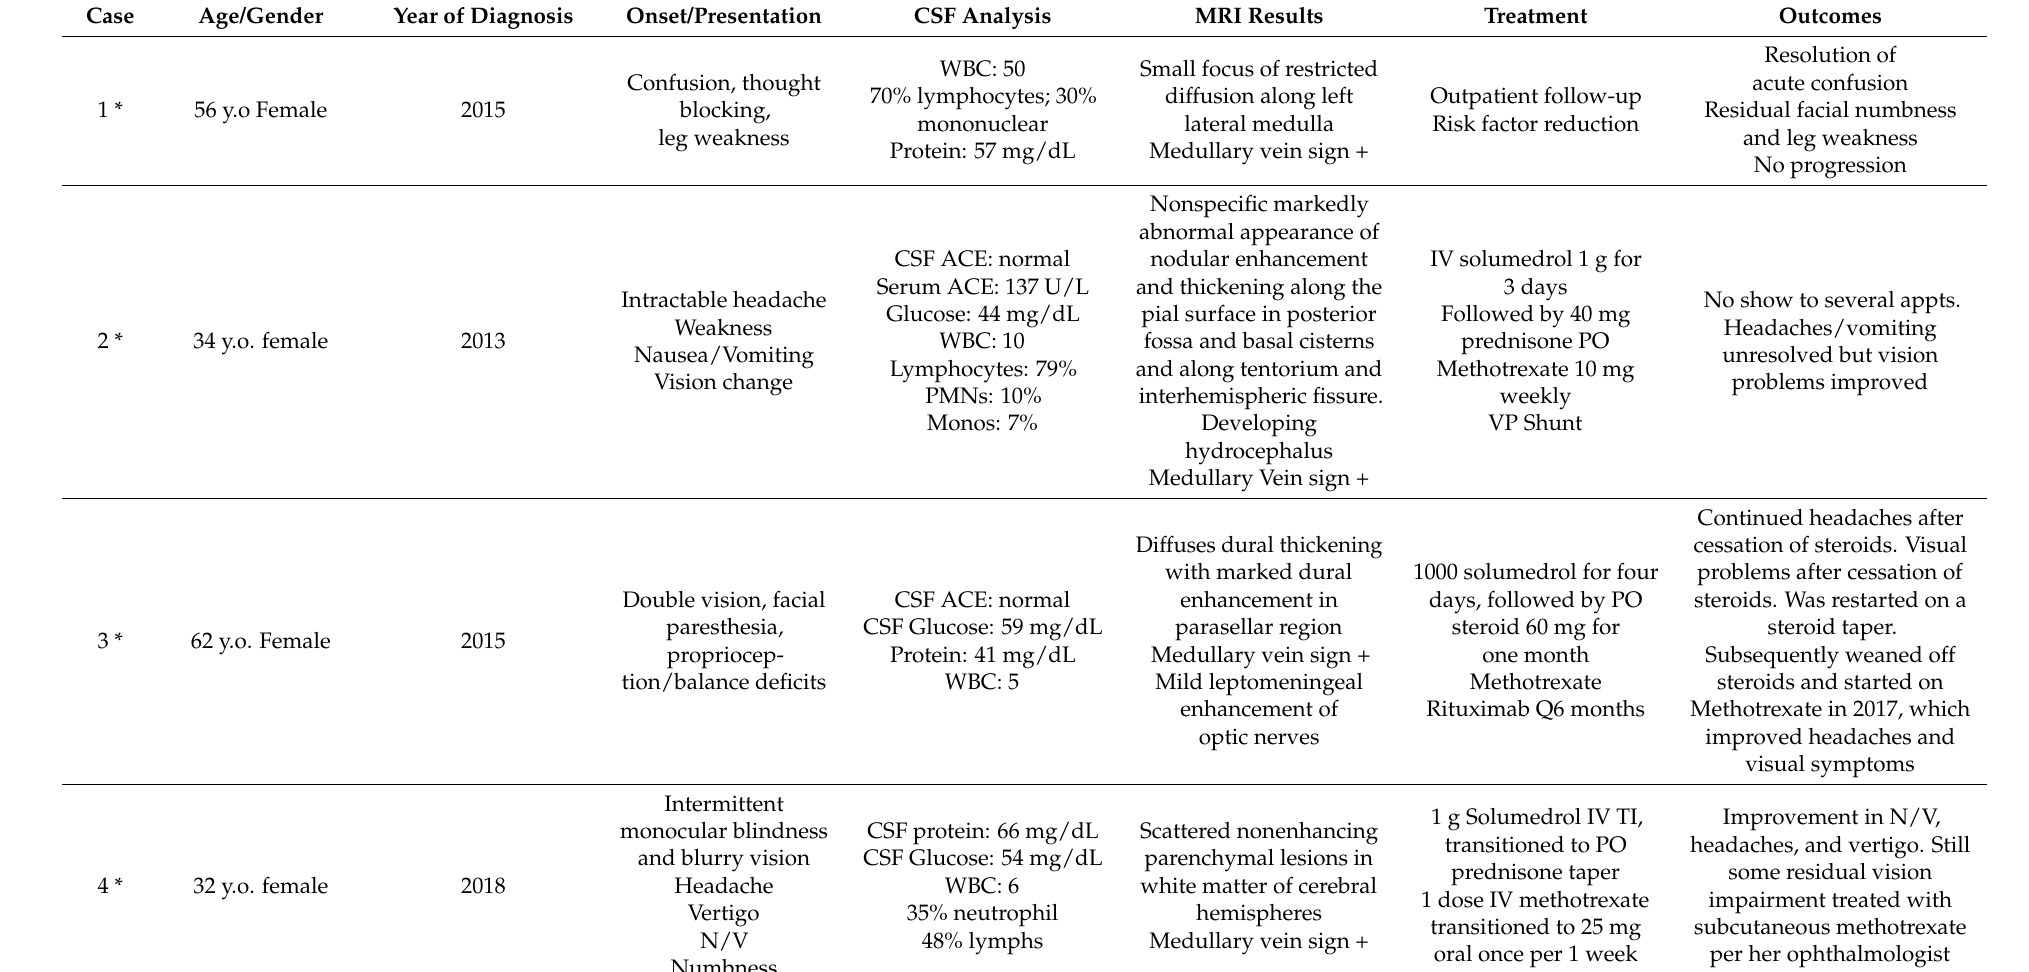
Table 1. MRI Imaging and image analysis findings. The table lists five cases of confirmed neurosarcoidosis with a positive medullary vein sign upon review of MRI imaging along with clinical presentation, MRI findings, CSF analysis, treatment, and clinical